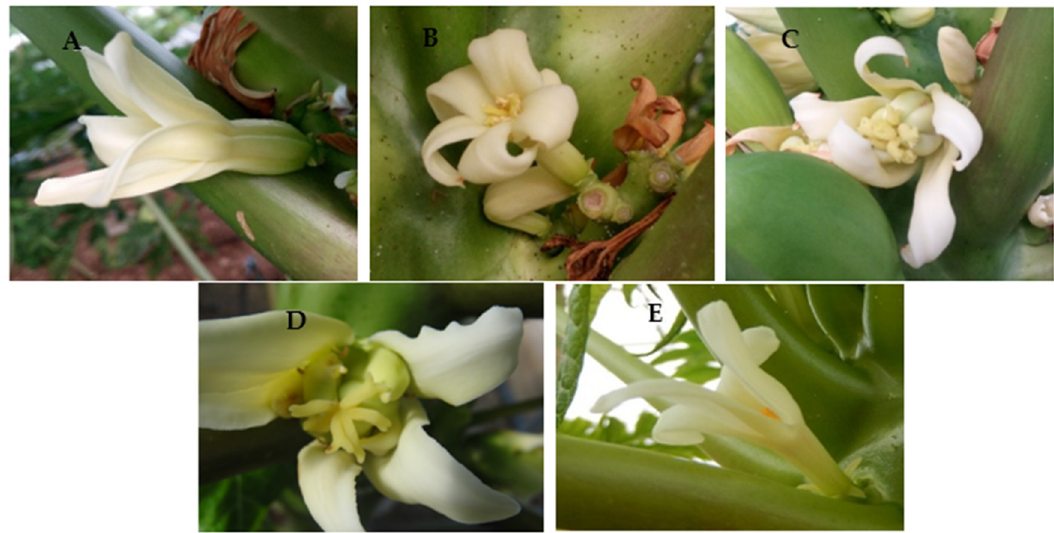
Figure 8. Main flower types described in papaya, evaluated in ‘Alicia’ papaya propagated by seed, grafting, and in vitro: ( A ) elongata flowers (those that will produce commercial fruits); ( B ) non- elongata, ( C ) pentandric, and ( D ) carpeloid misshapen flowers; and ( E ) functionally male flowers.